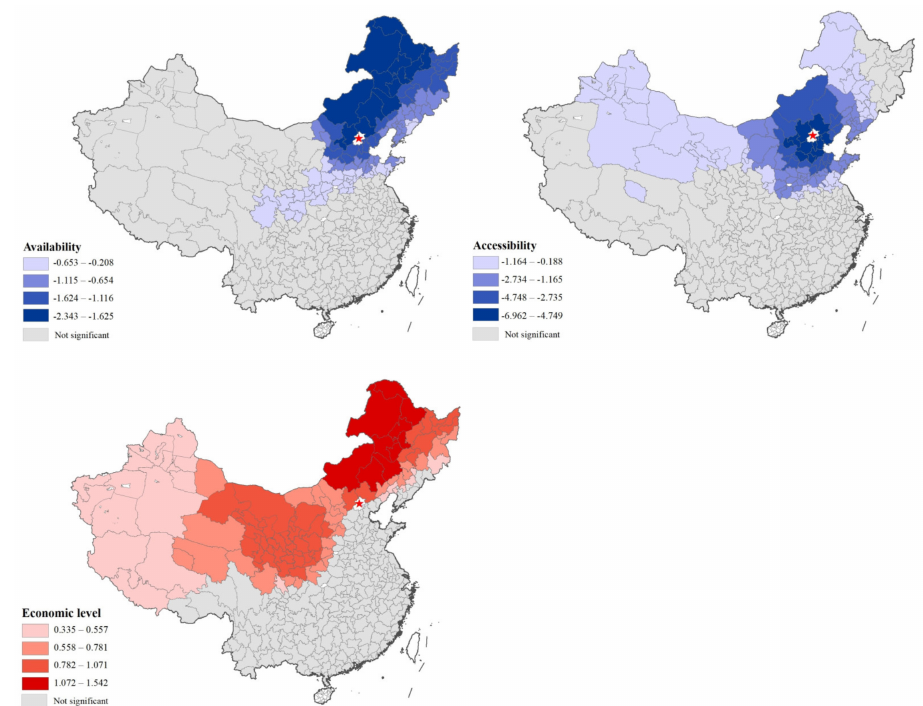
Figure 7. Spatial variations of local standardized coefficients to patient rate.